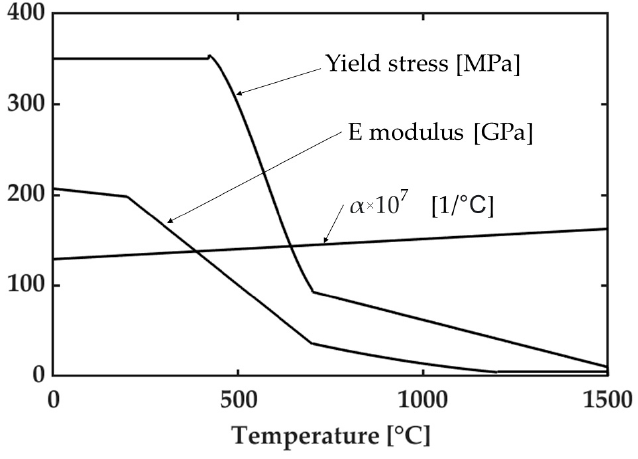
Figure 2. Material properties of S355 steel [28]. Material properties as a function of temperature can be also written in closed form as in Appendix